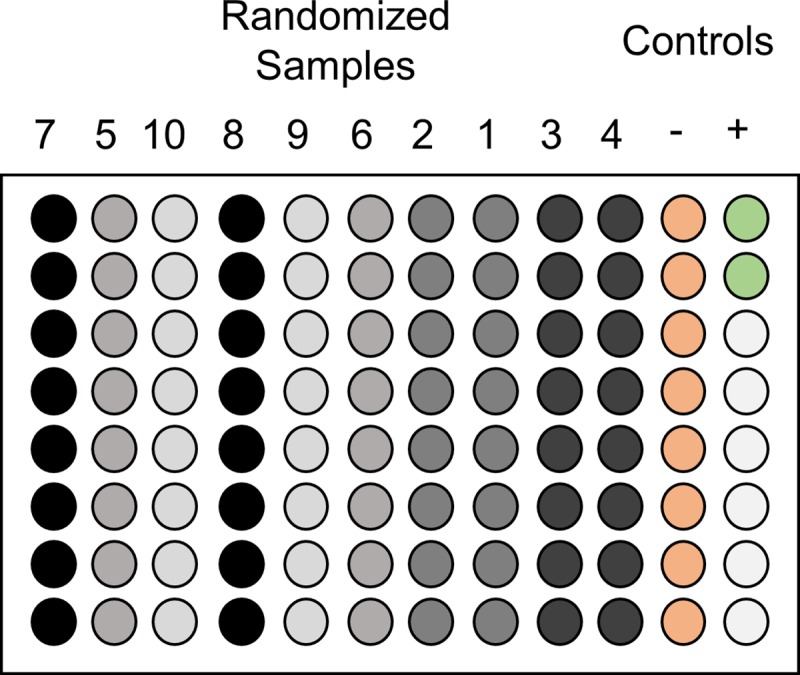
Sample orientation on qPCR plates plays an important role in the success of the eDNA assay.eDNA samples are randomized before DNA is isolated and the randomized samples are run in eight technical replicates for the eASTR4 test. Using the above layout spatially removes the positive control from the test samples to limit to chance of contaminating the test samples with pure target species total DNA. If a contamination event has occurred it will be detectable in the negative control right adjacent to the positive control.